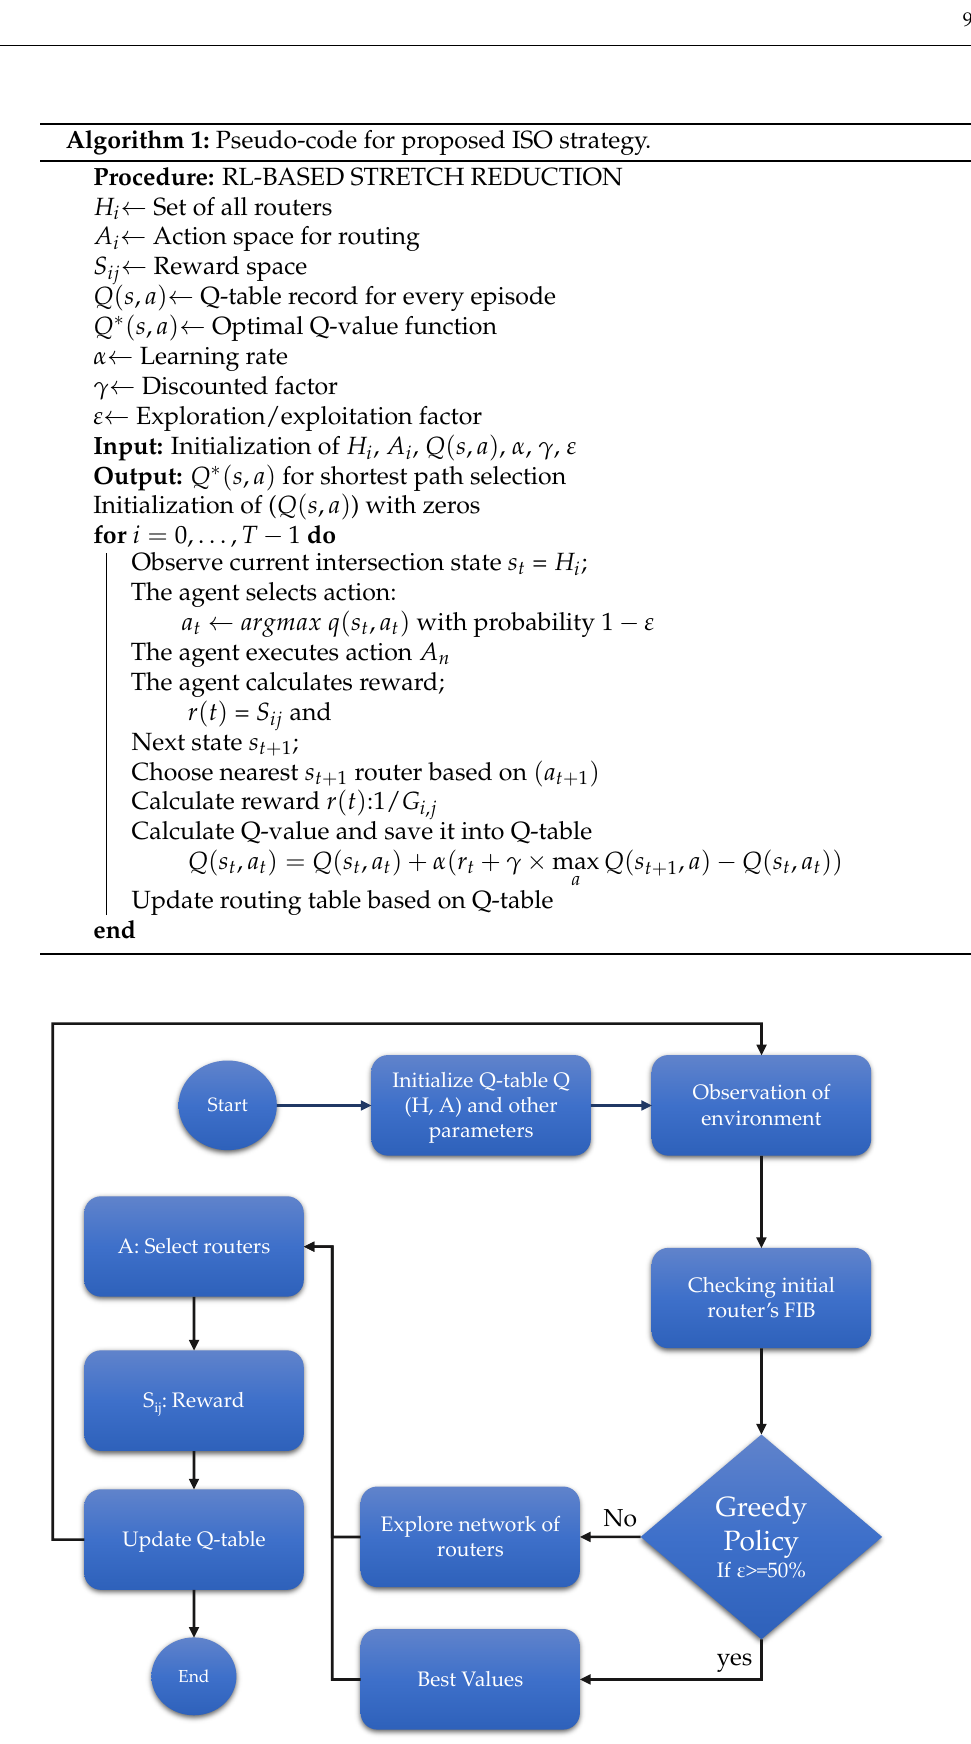
Figure 5. Q-learning algorithm for ISO